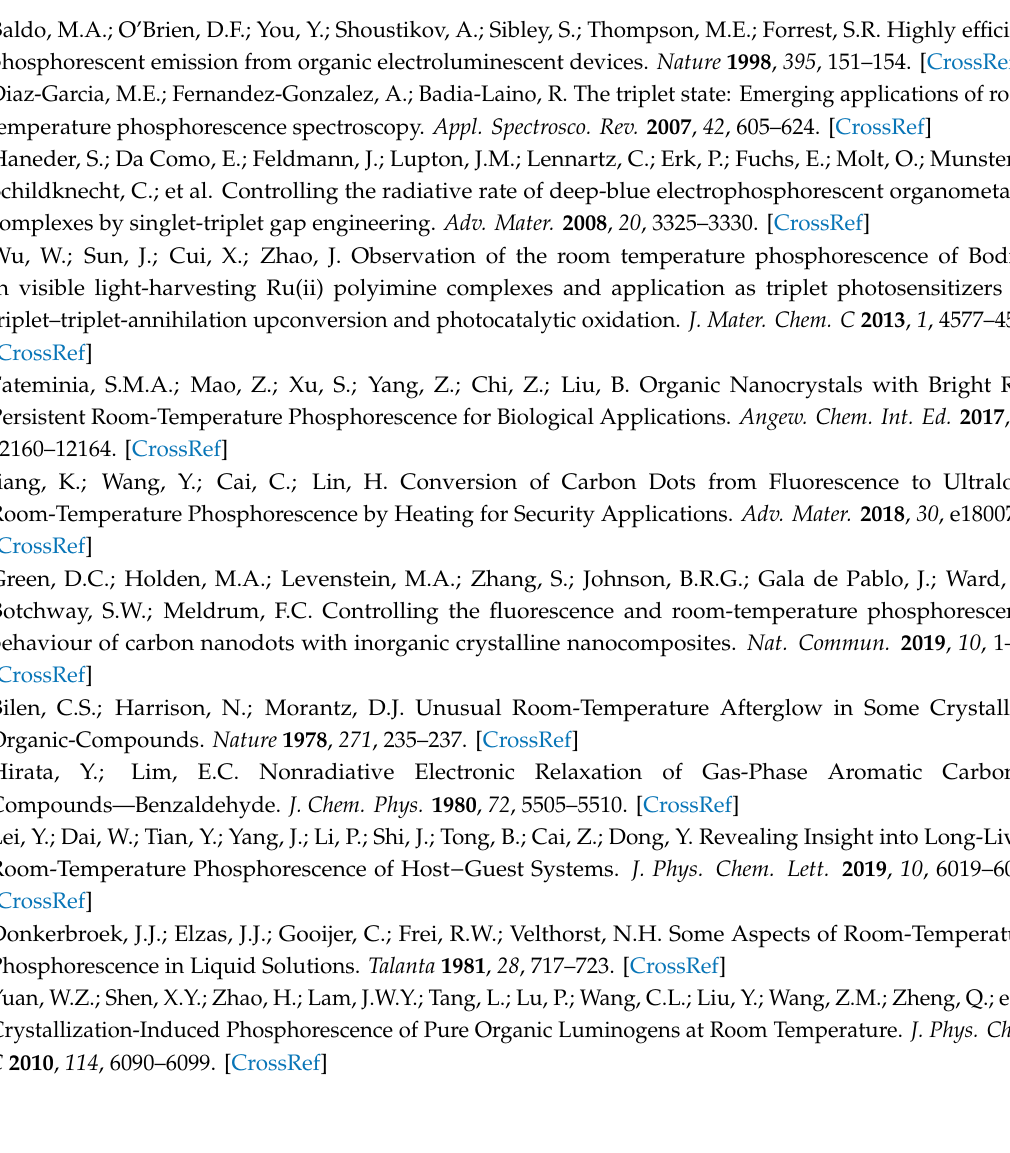
bubbling using Xe-355 nm lamp, Figure S6: Triple decay emission at 77 K of 1 – 3 in toluene solutions, Figure S7: TCSPC time profile of 3 at 400 nm taken from Figure 6c, Figure S8: Time profiles of flu. (1), flu. (2) and phos. bands of 1 – 3 in toluene solutions taken from Figure 5, Figure S9: Optimized structure of 1–3 in the ground triplet state obtained by DFT calculations [M06-2X / 6-31g(d)]. Table S1: Amplitudes (A n ) and time constants ( τ n ) estimated by theoretical curve fittings of time-profiles of PL spectra of 1–3 in toluene solutions measured at 77 K, Table S2: TD-DFT calculation results of 1 − 3 with optimized conformation at the ground triplet